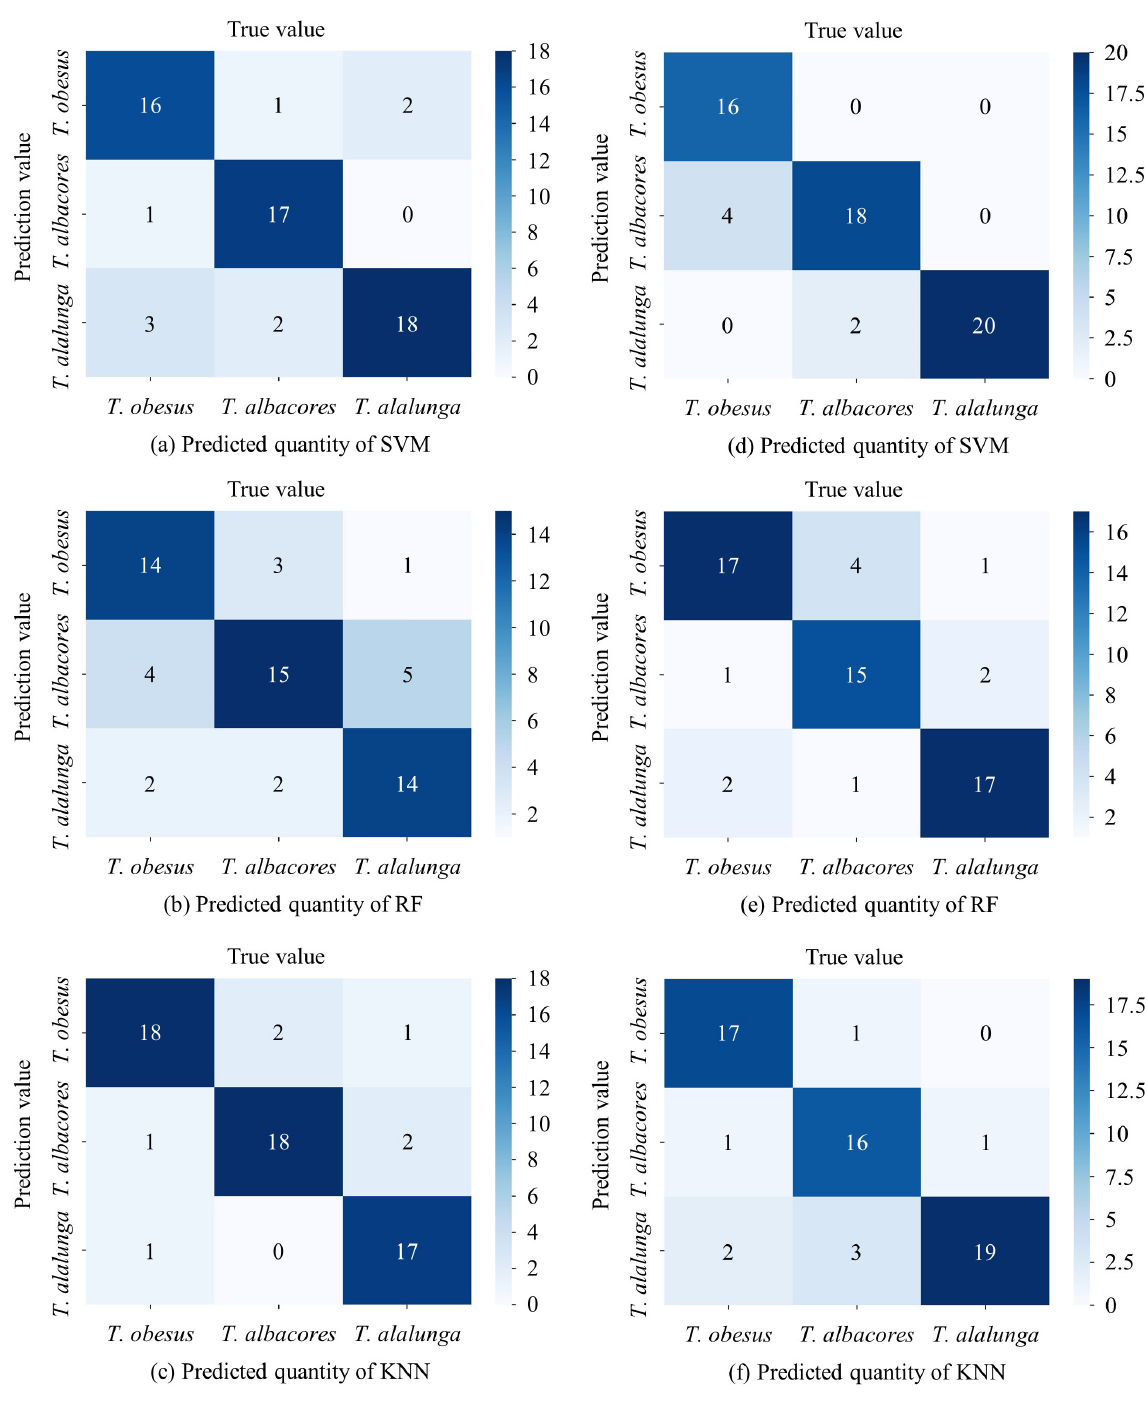
Figure 8. Predicted number of different machine learning algorithms in Thunnus species: from ( a ) to ( c ) is the confusion matrix of the EFT features; from ( d ) to ( f ) is the confusion matrix of the deep features; ( a ) and ( d ) represent SVM; ( b ) and ( e ) represent RF; ( c ) and ( f ) represent KNN.